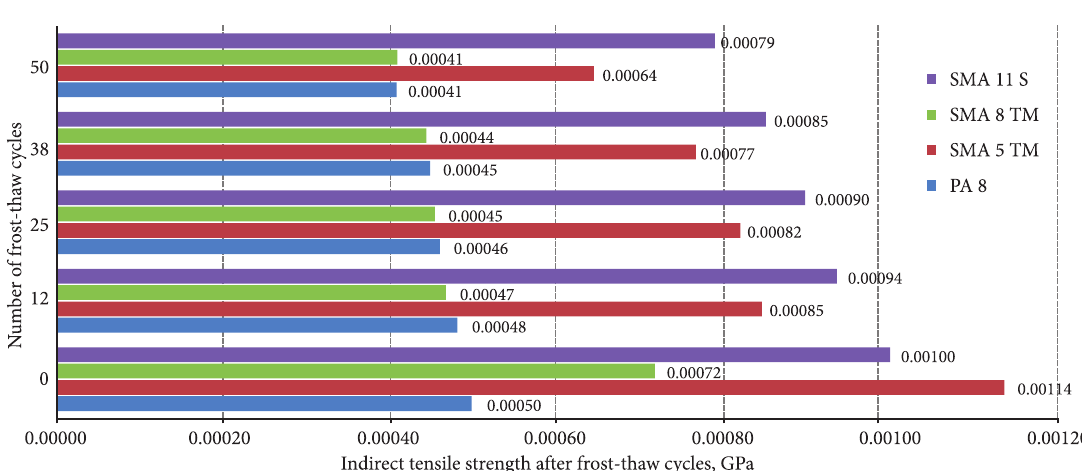
Fig. 7. Mechanical and physical characteristics testing results (from left: air void content; flow by Marshall; stability by Marshall; Indirect Tensile Strength Ratio (ITSR)